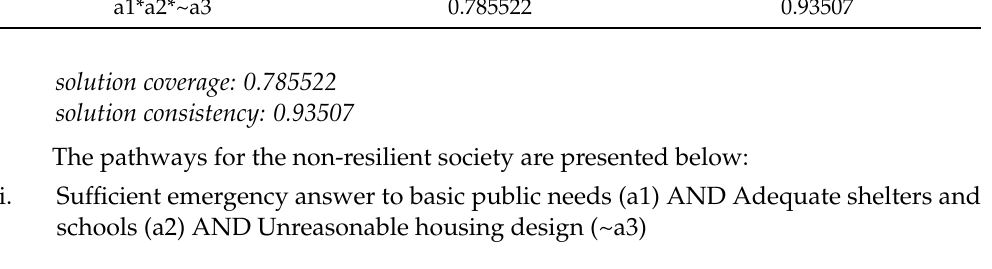
Table A6. Failure pathways (outcome A1)- The mark * resembles “and”. Solutions Raw Coverage